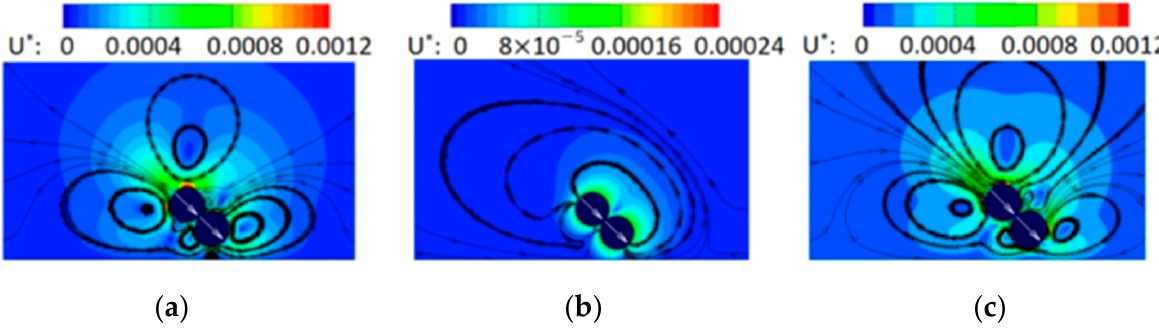
Figure 6. Distribution of the flow velocity and streamline: ( a ) β = − 5, ( b ) β = 0, ( c ) β = 5 ( Re s = 0.1).